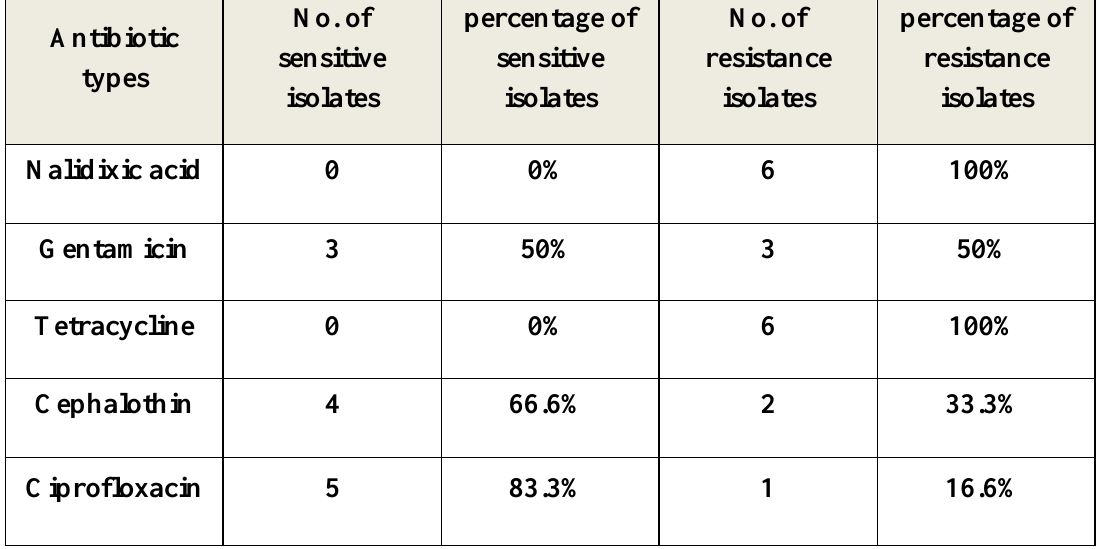
Table 2. Rate of antibiogram of mastitic isolates of P.